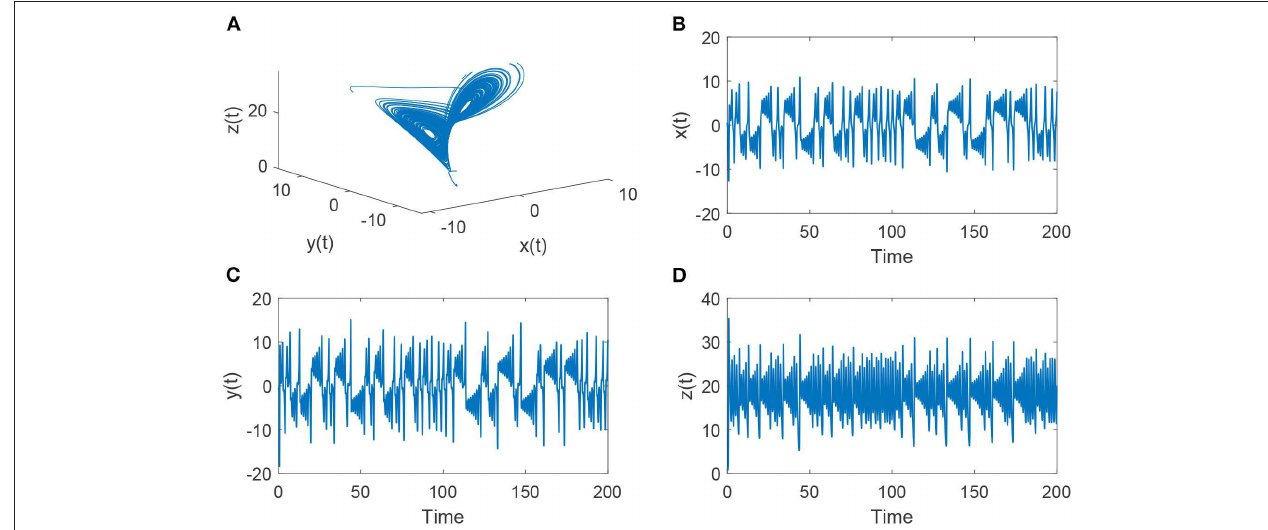
y z space, (B) x ( t ), (C) y ( t ), and (D) z ( t ). − −